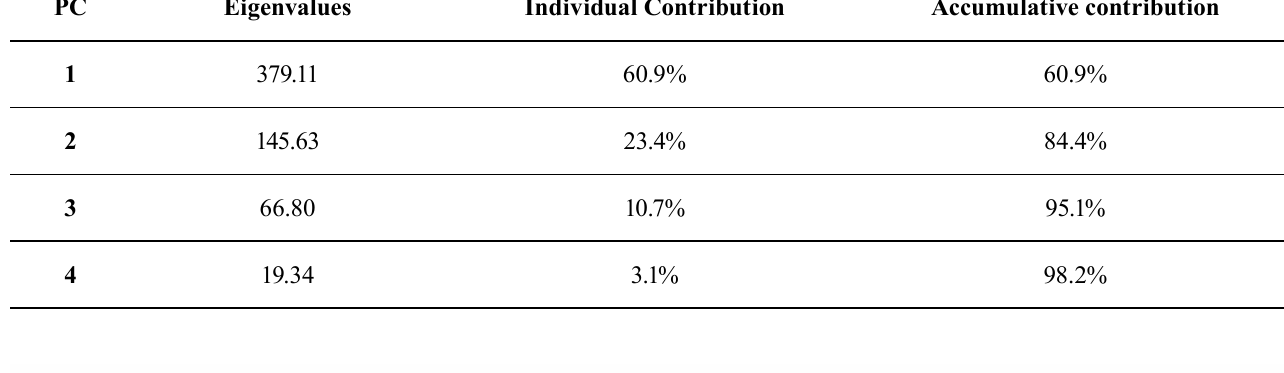
TABLE II – Principal components analysis (PCA) results obtained from FTIR-ATR spectra between 800 and 2000 cm -1 after first derivative and smoothing of Bacillus subtilis (ATCC 6633), Candida albicans (ATCC 10231), Enterococcus faecium (ATCC 8459), Escherichia coli (ATCC 8739), Micrococcus luteus (ATCC 10240), Pseudomonas aeruginosa (ATCC 9027), Salmonella typhimurium (ATCC 14028), Staphylococcus aureus (ATCC 6538), and Staphylococcus epidermidis (ATCC 12228) microbial growth